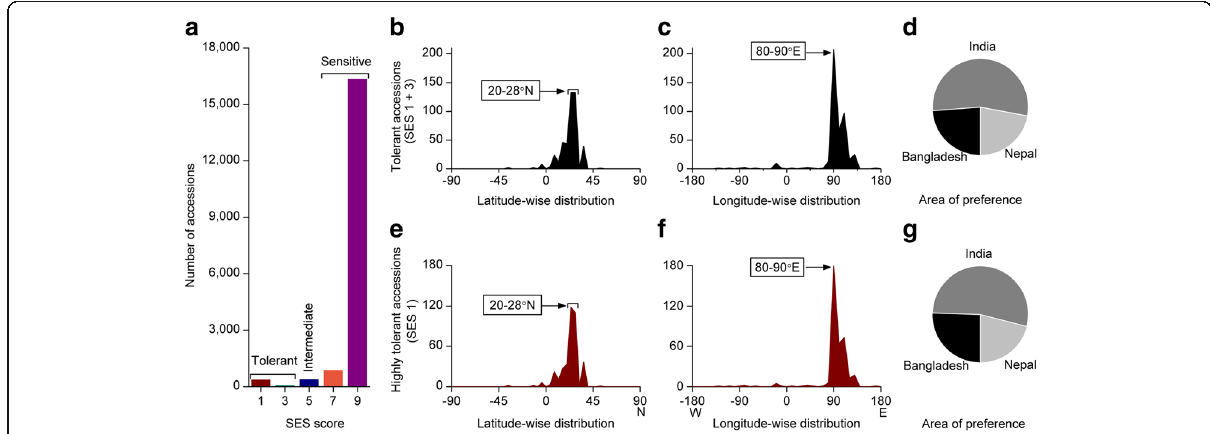
Fig. 6 Geographic distribution pattern of flash flood tolerant rice accessions. a Extent of flash flood tolerant accessions, b - d Geographic distribution pattern of flash flood tolerant (SES score 1-3) accessions, b Latitude-wise distribution, c Longitude-wide distribution, d Area of preference, e - g Geographic distribution pattern of highly tolerant (SES score 1) accessions, e Latitude-wise distribution, f Longitude-wide distribution, g Area of preference. List of highly tolerant accessions can be found in Additional file 4: Table